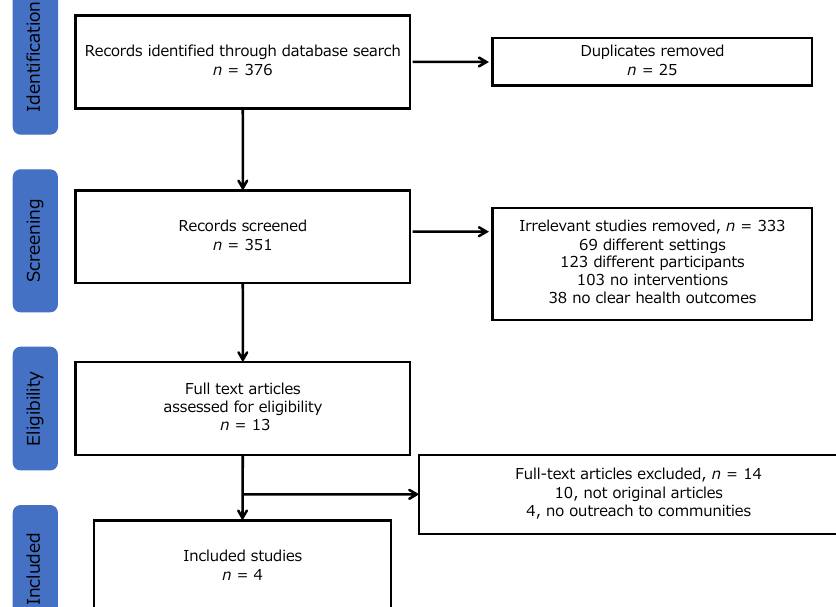
Figure 1. Study selection flow.